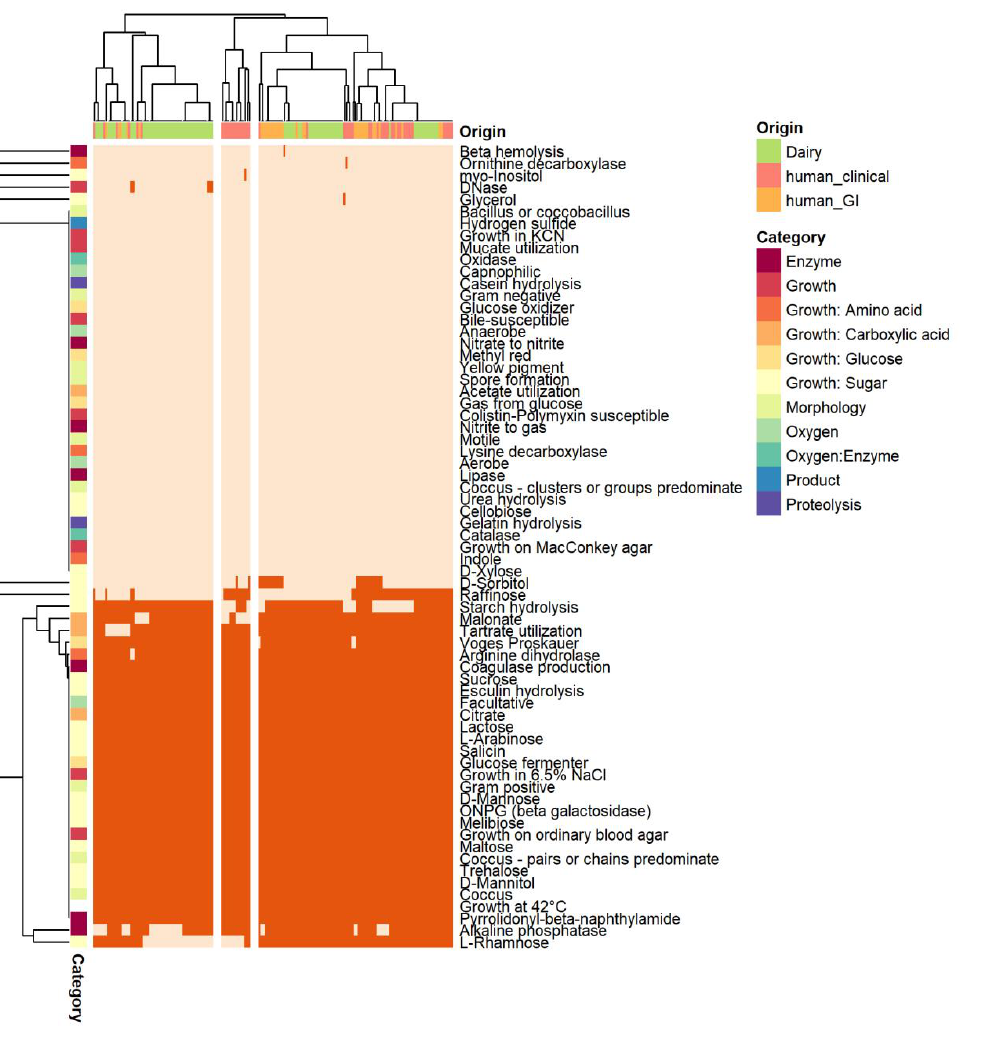
Figure 6. Predicted phenotypic characteristics of E. faecium isolates with Traitar.